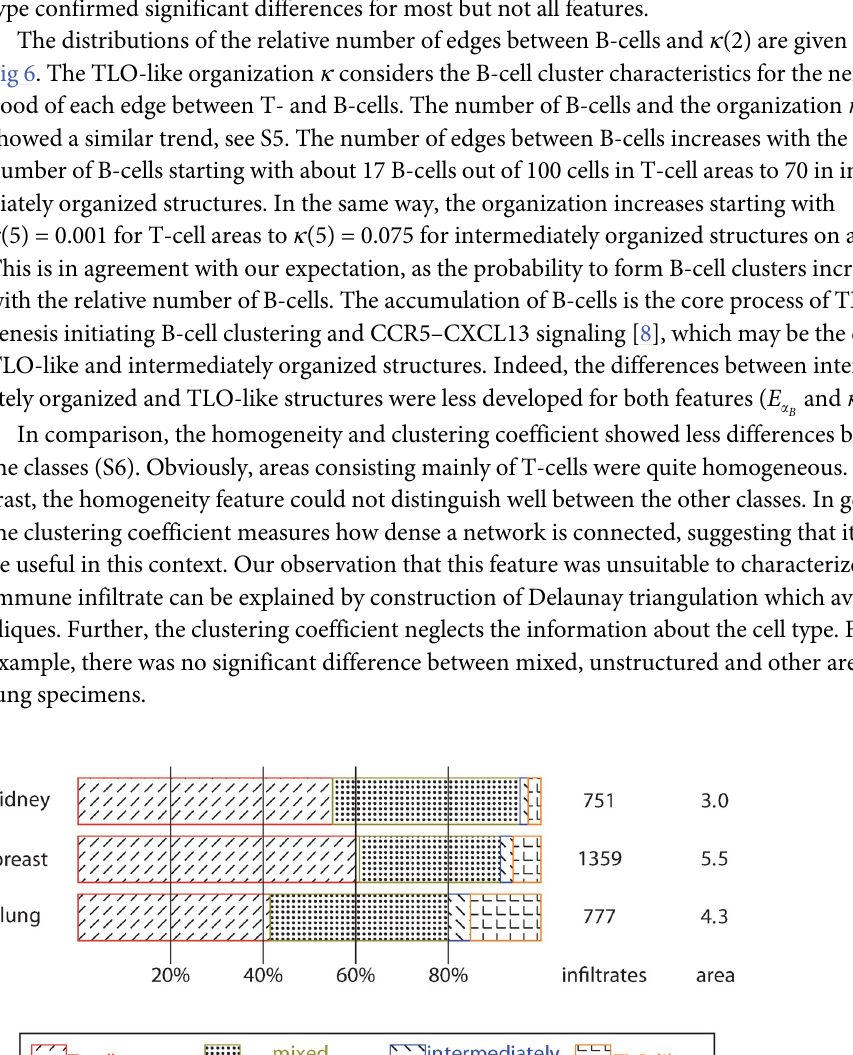
Fig 5. Composition of infiltrates: The absolute number of infiltrates and the estimated area considered to detect infiltrates (given in mm 2 ).